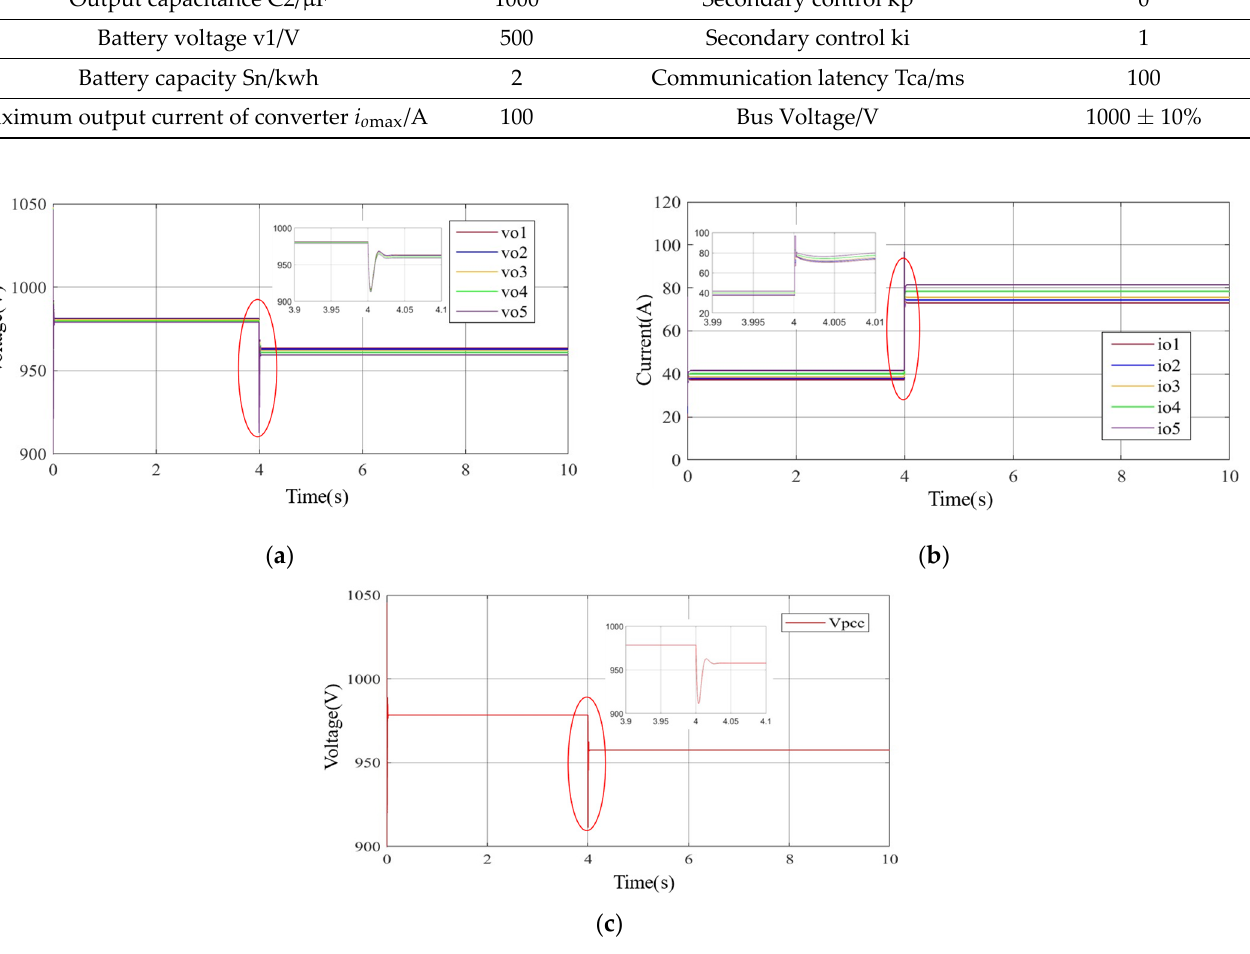
Figure 8. Simulation without secondary control: ( a ) output voltages of converters; ( b ) output cur- rents of converters; ( c ) DC bus voltage.